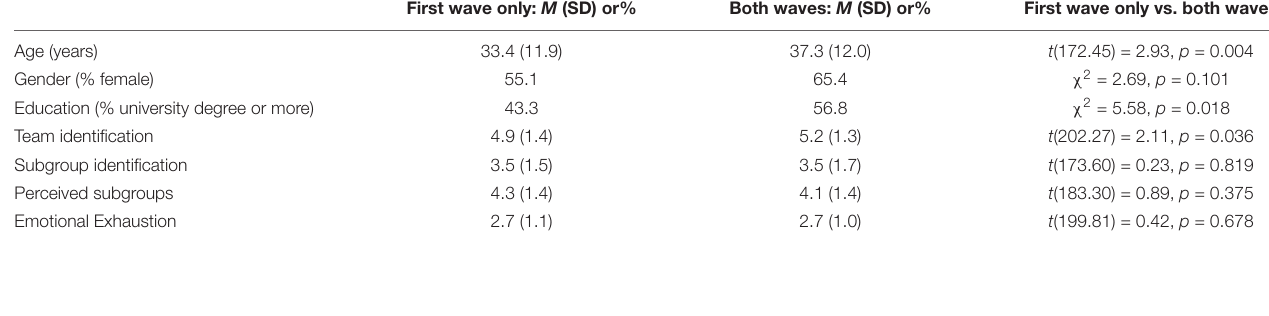
TABLE A2 | Sample description and comparisons of (a) all participants who completed only the first questionnaire ( N = 358) and (b) participants who completed both the first and the second questionnaire ( N = 112). First wave only: M (SD) or% Both waves: M (SD) or% First wave only vs. both